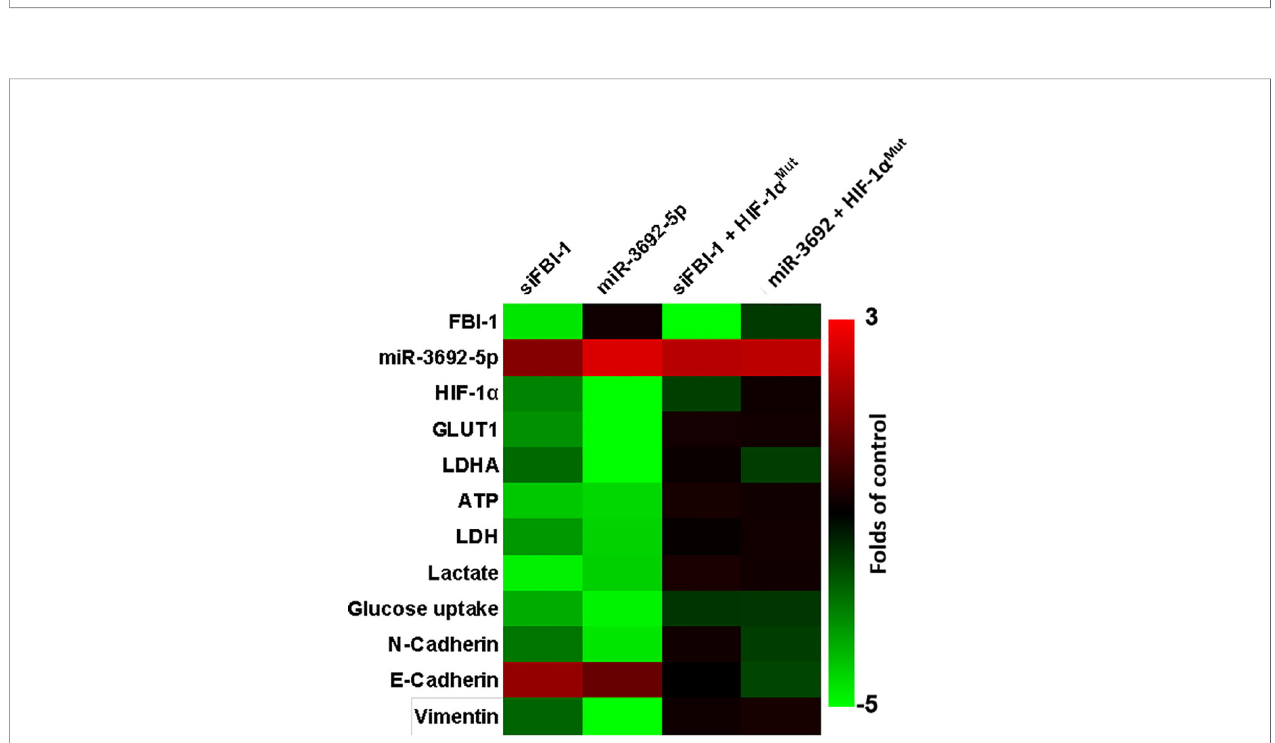
FIGURE 3 | FBI-1 on miR-3692-5p/HIF-1 a . (A) miR-3692-5p targets on HIF-1 a ’ s 3 ’ -UTR. (B) The effect of FBI-1 on the miRNAs on HIF-1 a . (C, D) The effect of miR-3693-5p on HIF-1 a in MHCC97-H or HepG2 cells. (E – H) The correlation between miR-3692-5p with FBI-1, HIF-1 a , LDHA, or GLUT1. *p < 0.05 versus control siRNA with siFBI-1 (B) .